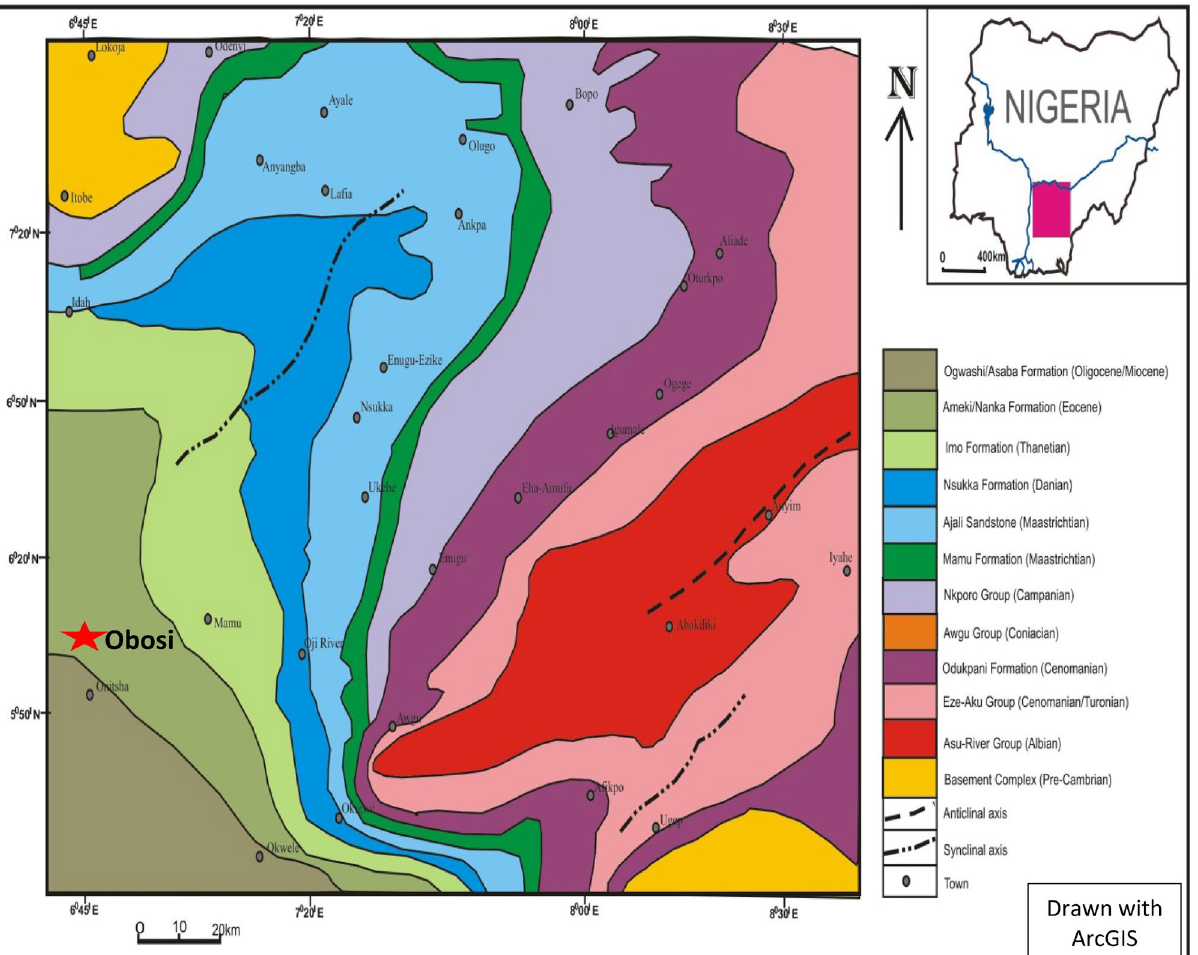
Figure 3. Geologic map of southeastern Nigeria showing the study area marked in red star (modified from 20